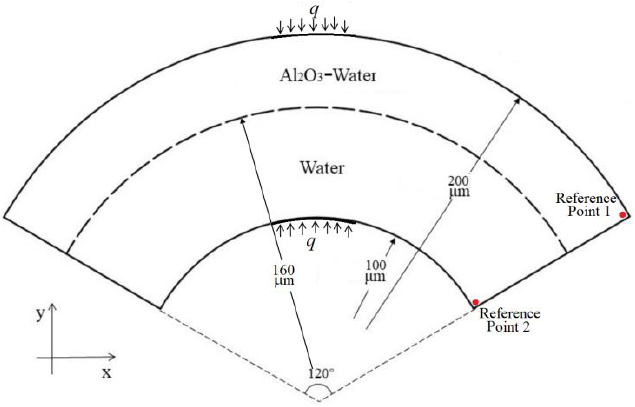
Table 2. Comparisons of the numerical results and that presented in Reference [38].